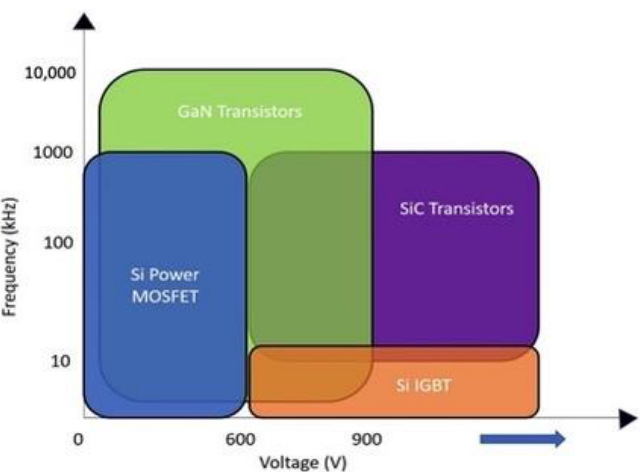
Figure 7. Approximate transistor operating voltage range vs. frequency of operation.